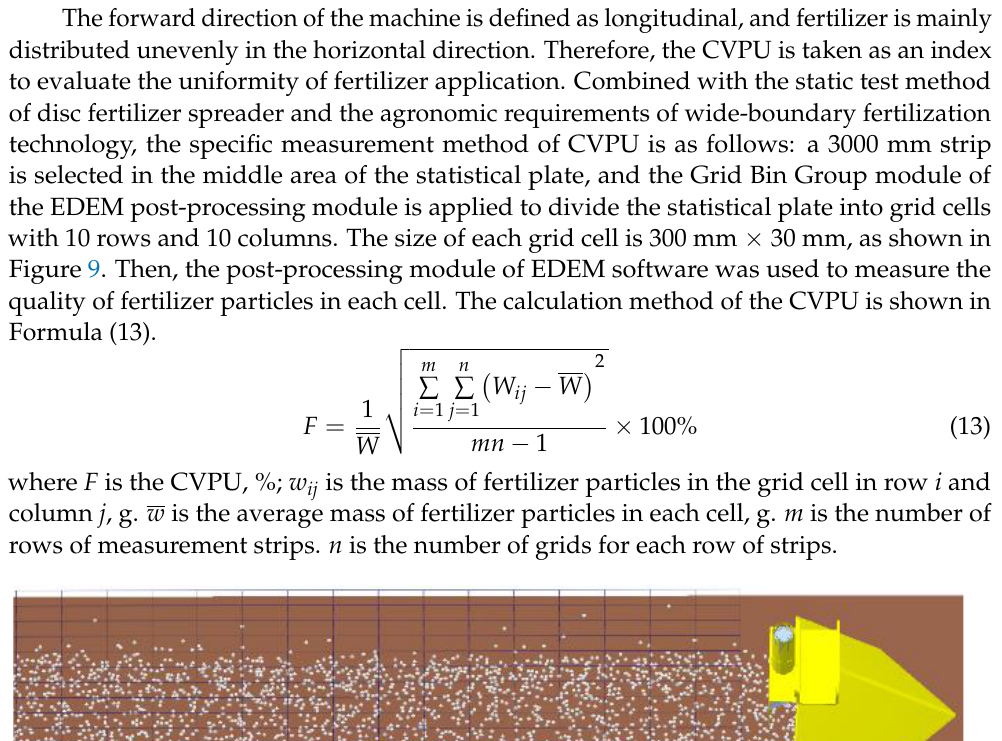
Table 5. Variance analysis of regression equation.